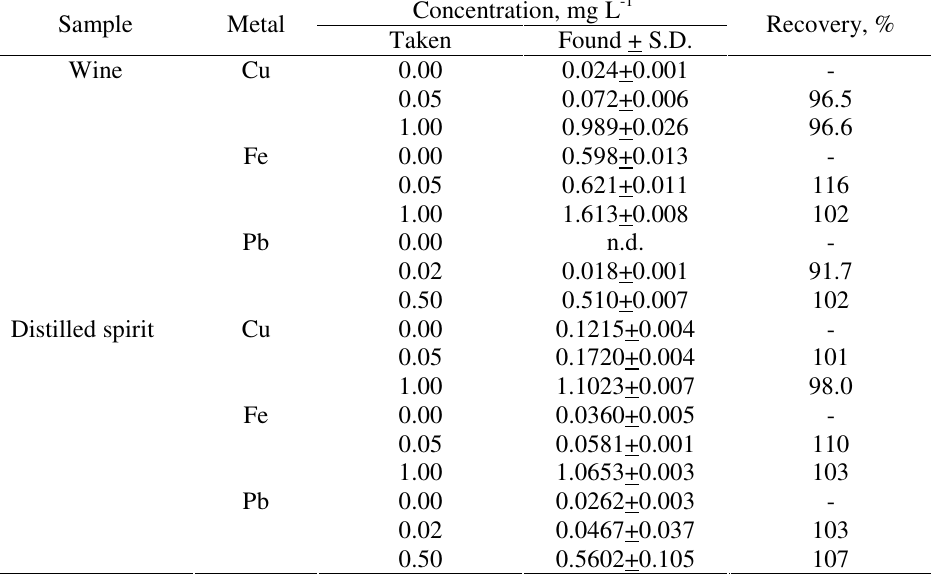
Table 6. Recovery of Cu, Fe and Pb in the spiked sample determined by the